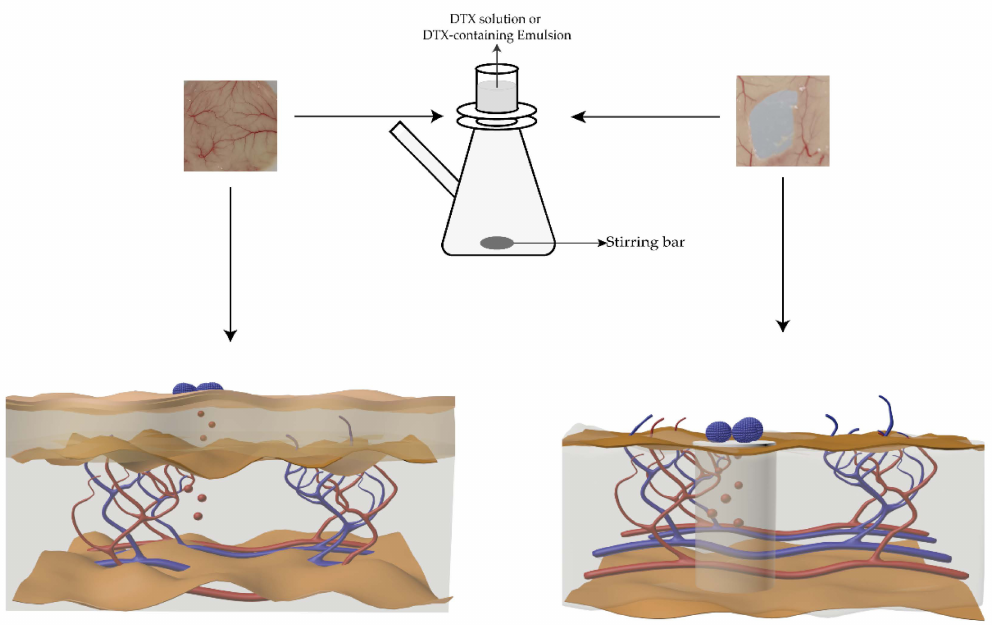
Figure 2. Schematic diagram of drug release experiments ex vivo. The left figure shows the DTX release from the emulsion across the mouse skin, and the right figure shows the DTX release from the emulsion across the mouse subcutaneous